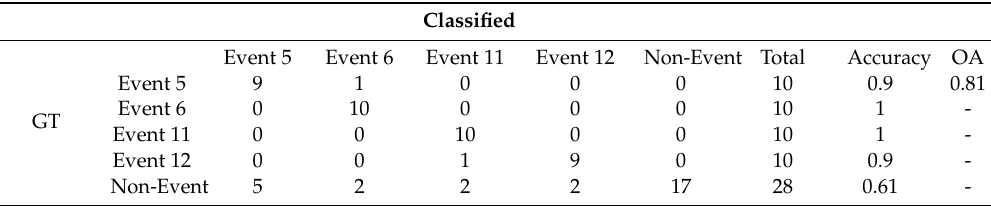
Table 4. Event classification performance using a hybrid approach only for 20 VIRAT videos. Confusion matrix and OA are included.